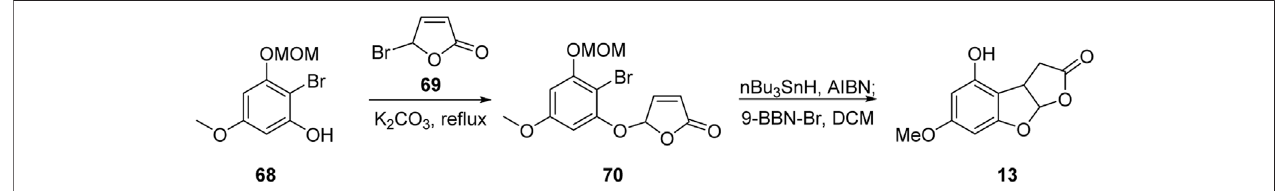
FIGURE 9 | Formal total synthesis of a fl atoxin B